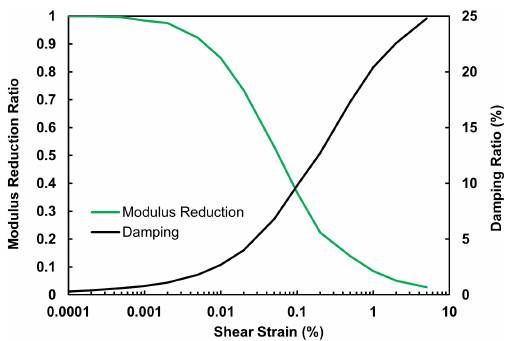
Figure 5. Average modulus reduction ratio and damping ratio adopted for sand (Seed and Idriss,